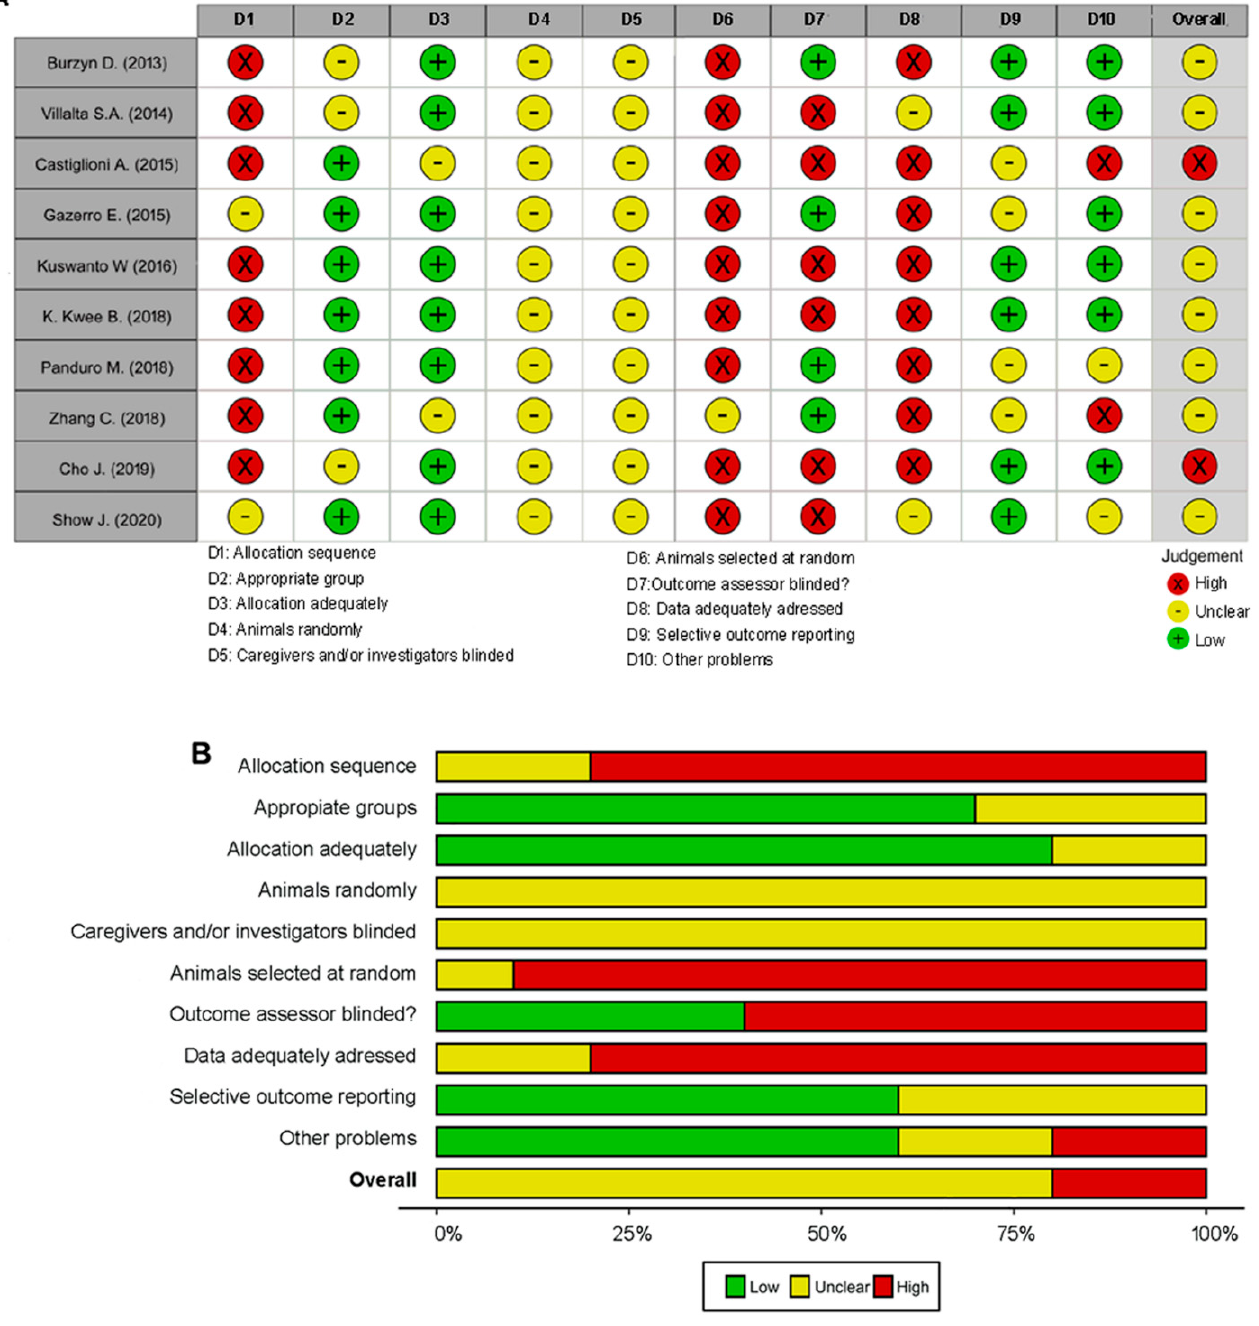
Figure 2. Risk of bias assessment. The Systematic Review Centre for Laboratory Animal Experimen- tation was used to assess the risk of bias in the included studies. Green—low risk of bias; red—high risk of bias; yellow—unclear risk of bias. ( A ) Individual studies of bias analysis based on SYRCLE methodology. ( B ) An overview of results.